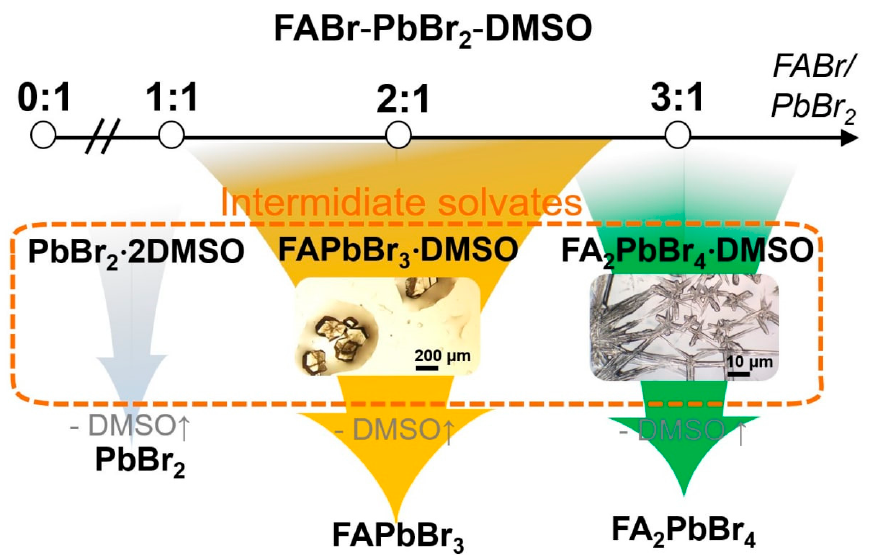
Figure 2. Phase diversity scheme of and FABr-PbBr 2 -DMSO system with different FABr:PbBr 2 ratios. The approximate regions of the phase coexistence fields are shown by overlapping colored arrows.